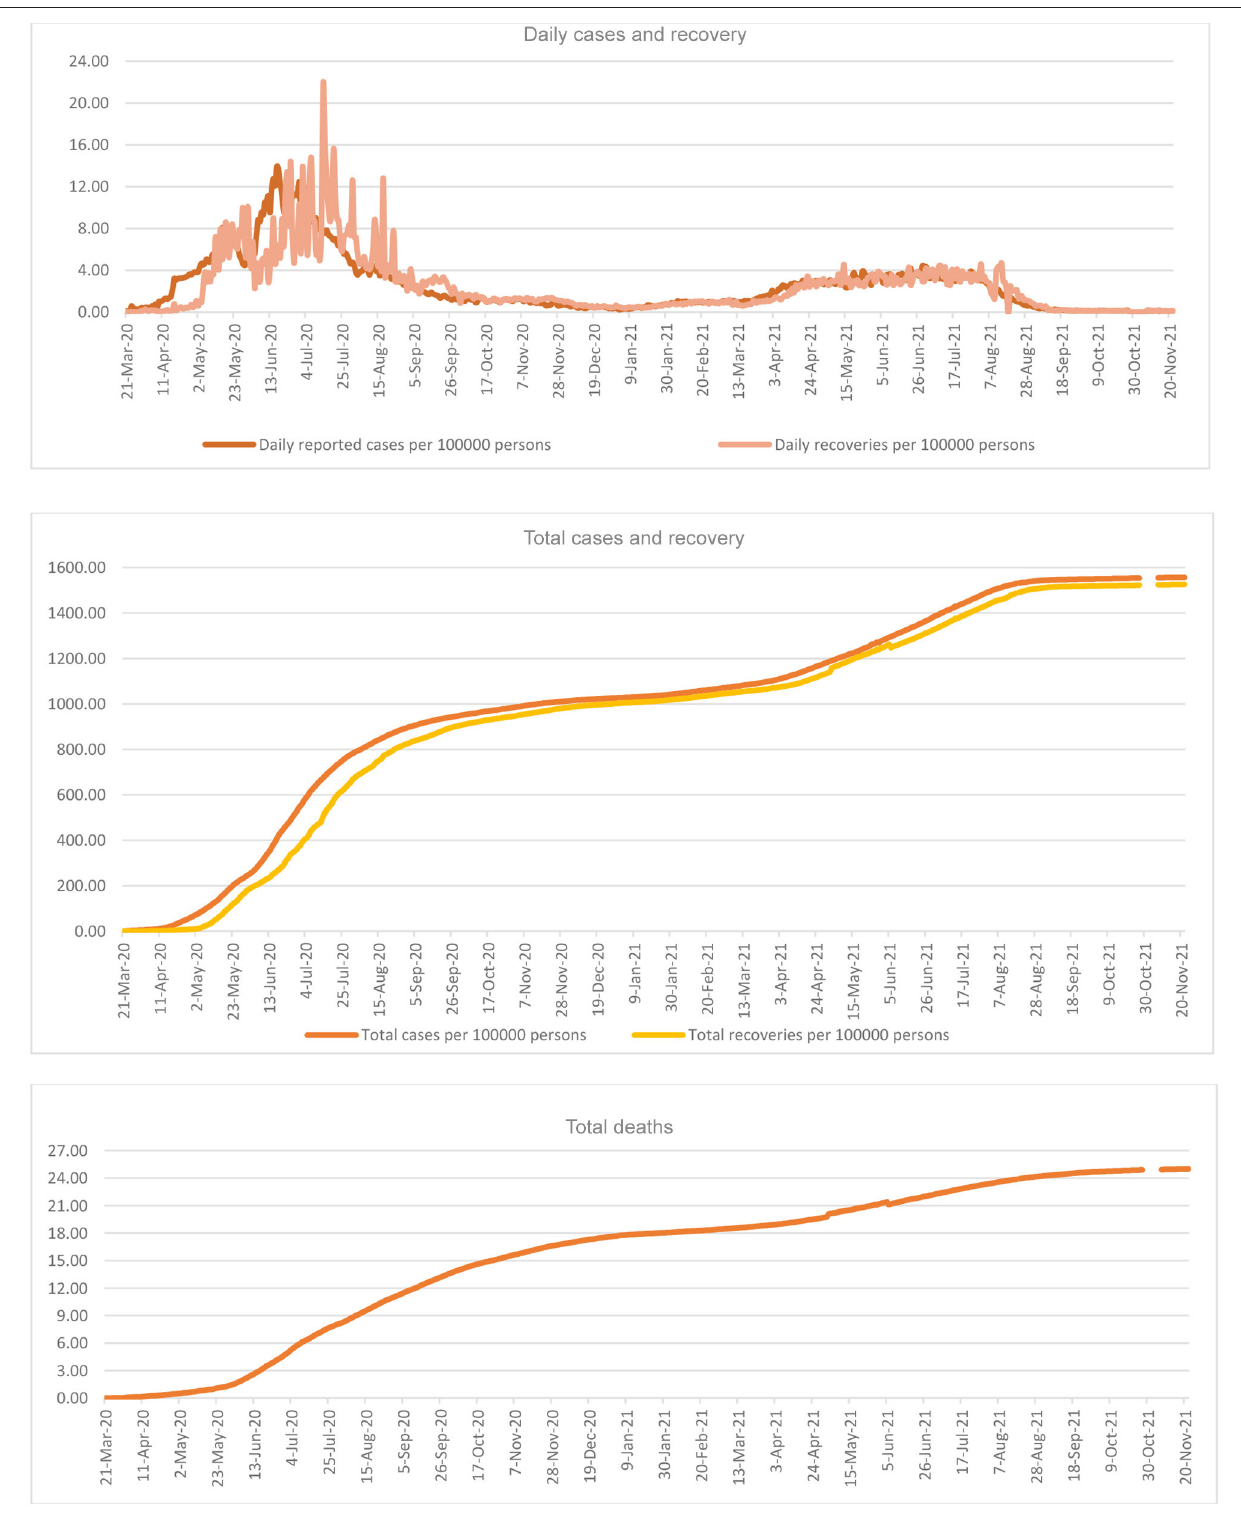
Frontiers in Public Health |